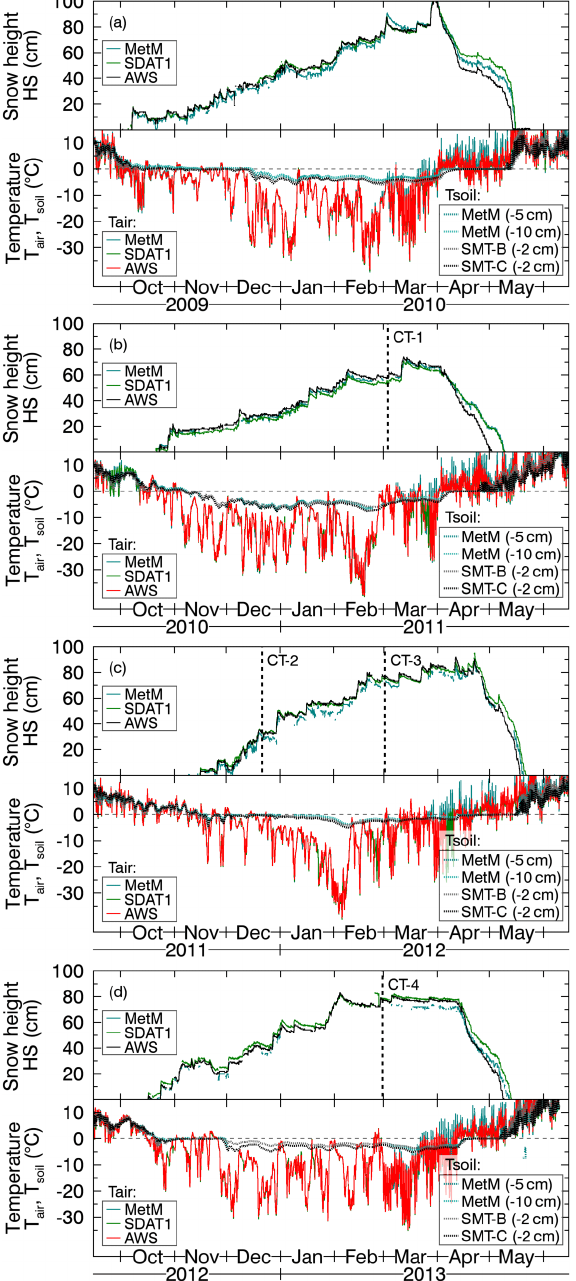
Figure 10. Snow height and air and soil temperature at different locations (IOA, AWS; MetM is meteorological